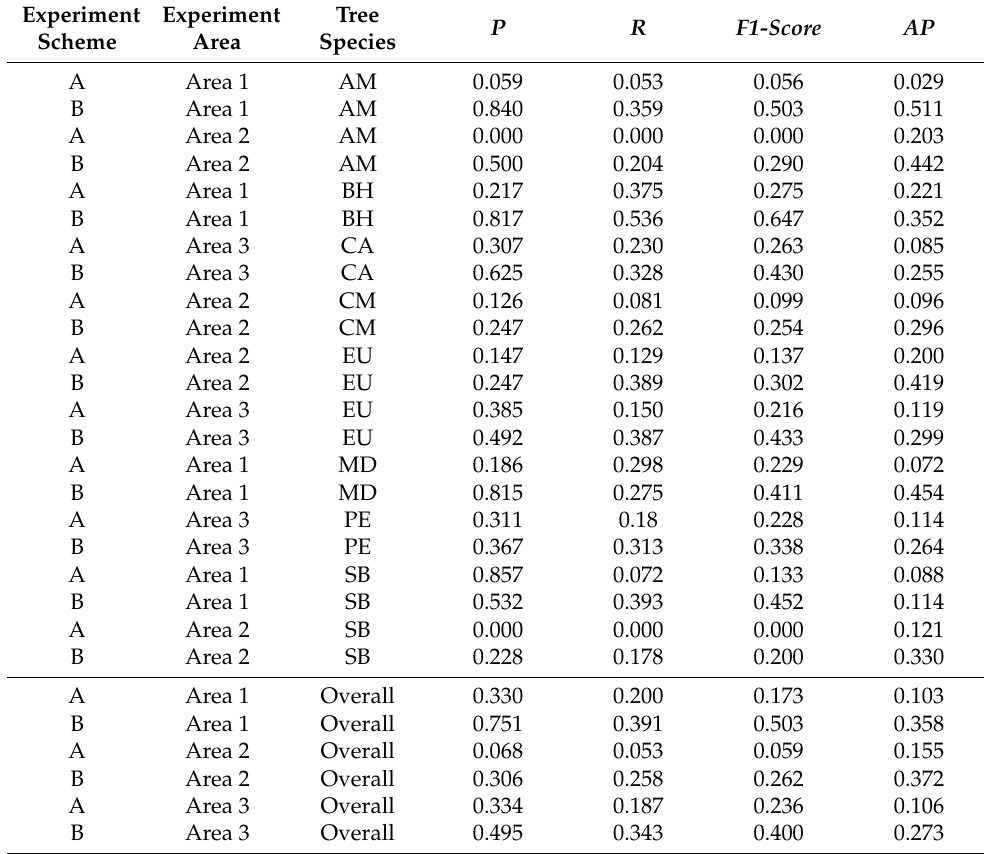
Table 5. Accuracy evaluation of individual tree species identification with different input data.